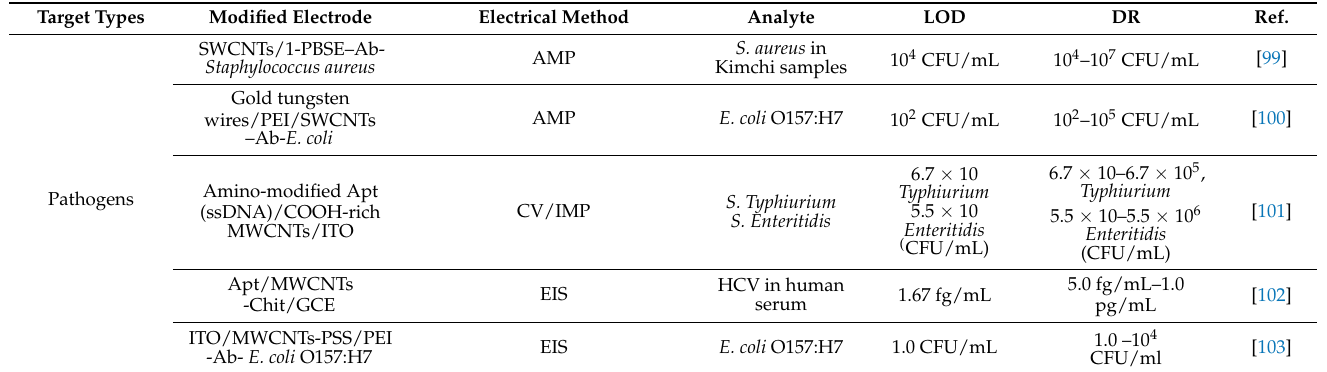
Table 2. Summary of CNT-based electrochemical biosensors for food